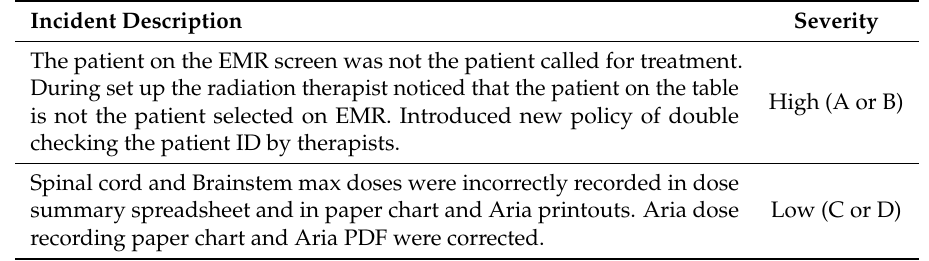
Table 1. Examples of Incident description and respective Severity assigned by Subject Matter Experts. Incident